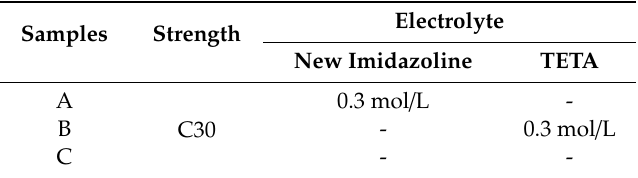
Figure 7. Test site. Table 3. Samples of